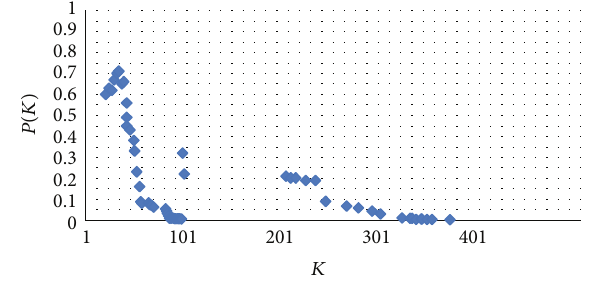
Figure 2: Initial distribution of